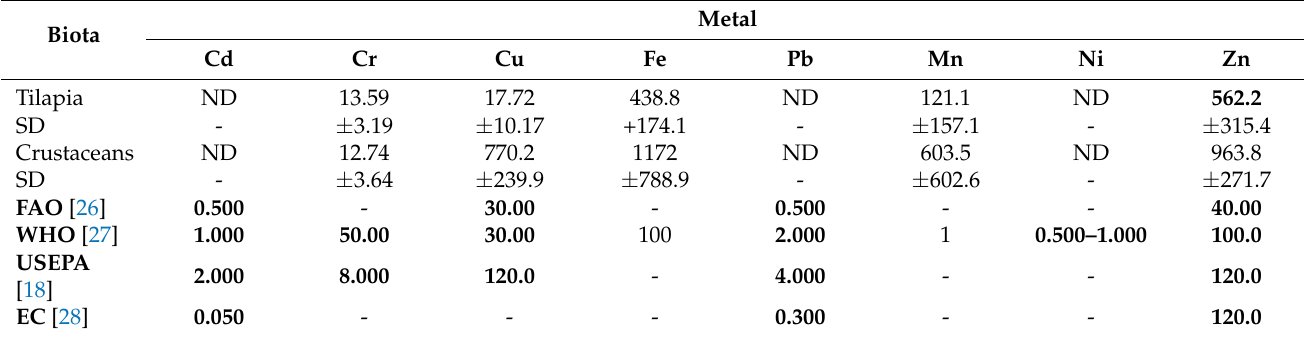
Table 5. Concentrations of toxic metals in crustaceans and tilapia (mg kg − 1 w.w.) with MPL.